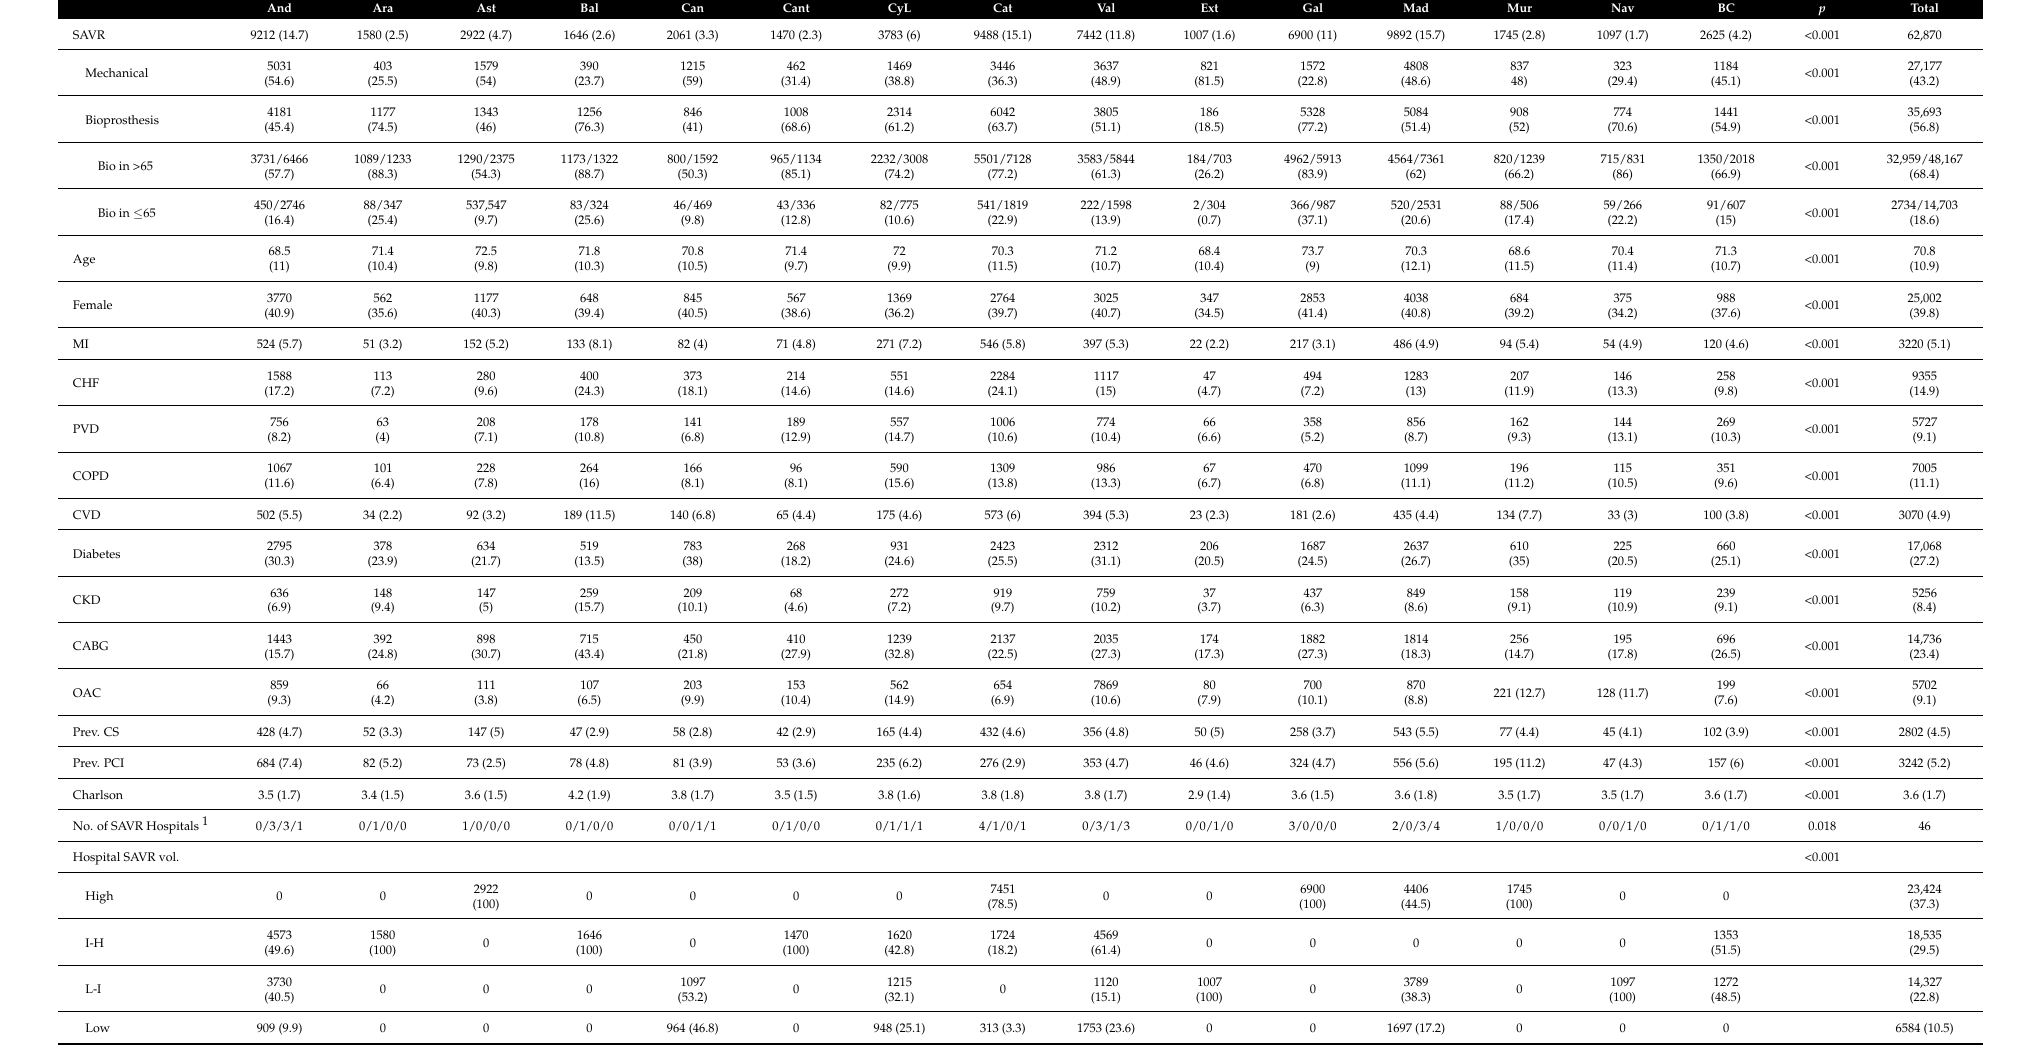
Table 1. Risk profile of patients undergoing surgical aortic valve replacement in the Autonomous Communities of